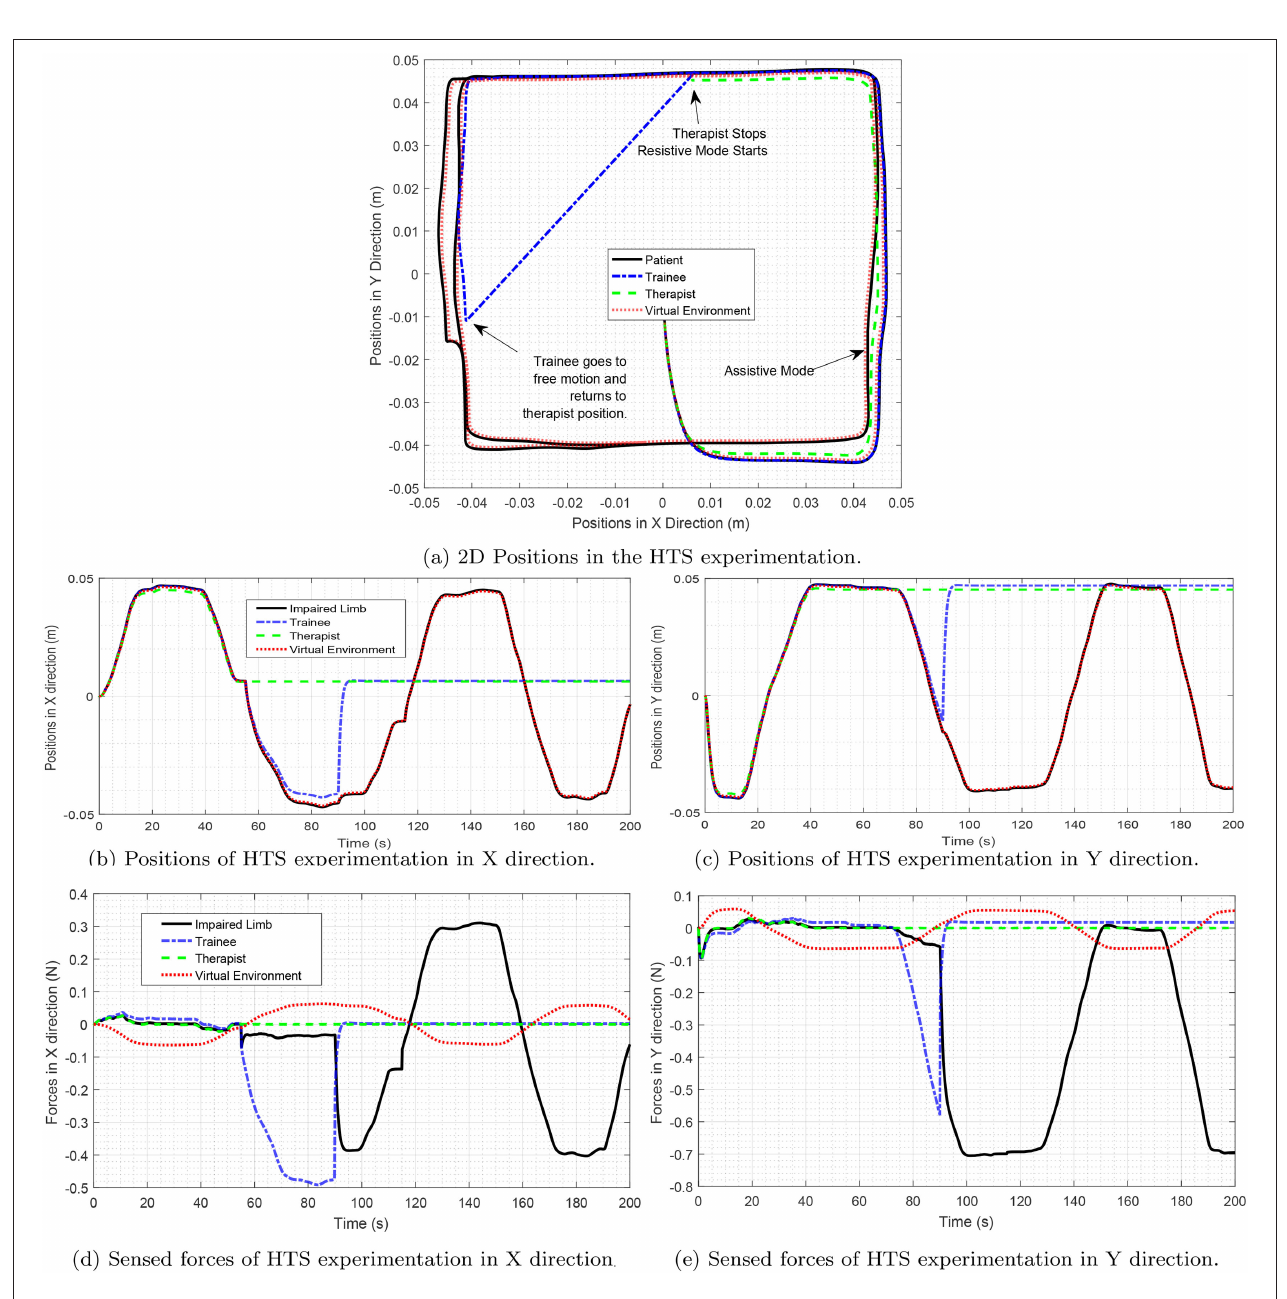
FIGURE 8 | Forces in hierarchical therapy. This figure illustrates three phases of therapy. In the first phase, all the operators participate in the TR process. So, the therapist assists all of them to move in the correct path. In the second phase, when the therapist stops moving, the trainee’s force is of larger magnitude. Moreover, in the third phase, the patient’s force increases. The phase stage, is resistive for the trainee, that helps them to learn the process of rehabilitation. The third phase, is resistive for the patient trainee.